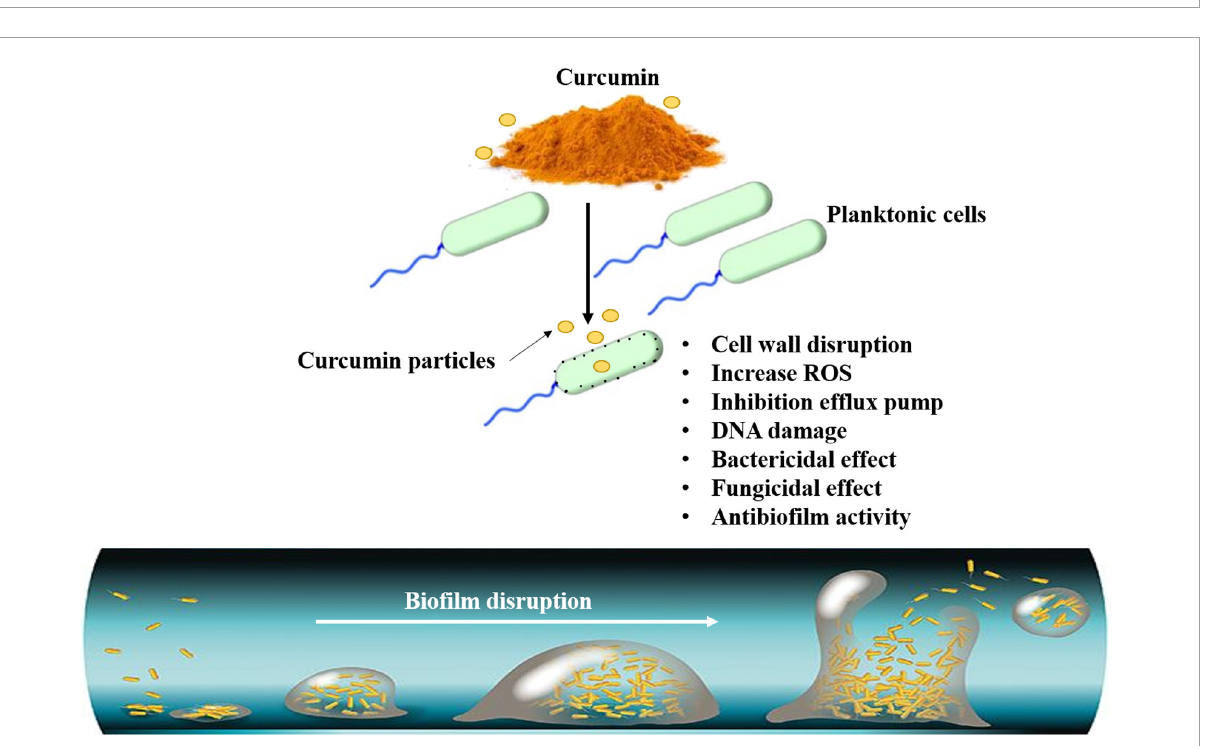
FIGURE6 Antibiofilm mechanism of bioavailable curcumin against pathogenic microorganisms.